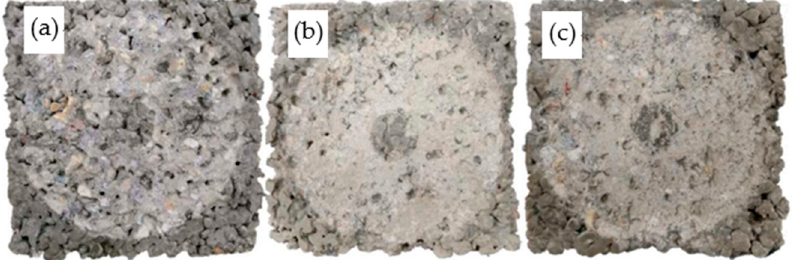
Figure 10. Surface changes of 8% FAG PCPC after abrasion test. ( a ) Without wet-dry cycles, ( b ) 12 wet-dry cycles in water, and ( c ) 12 wet-dry cycles in acid rain.